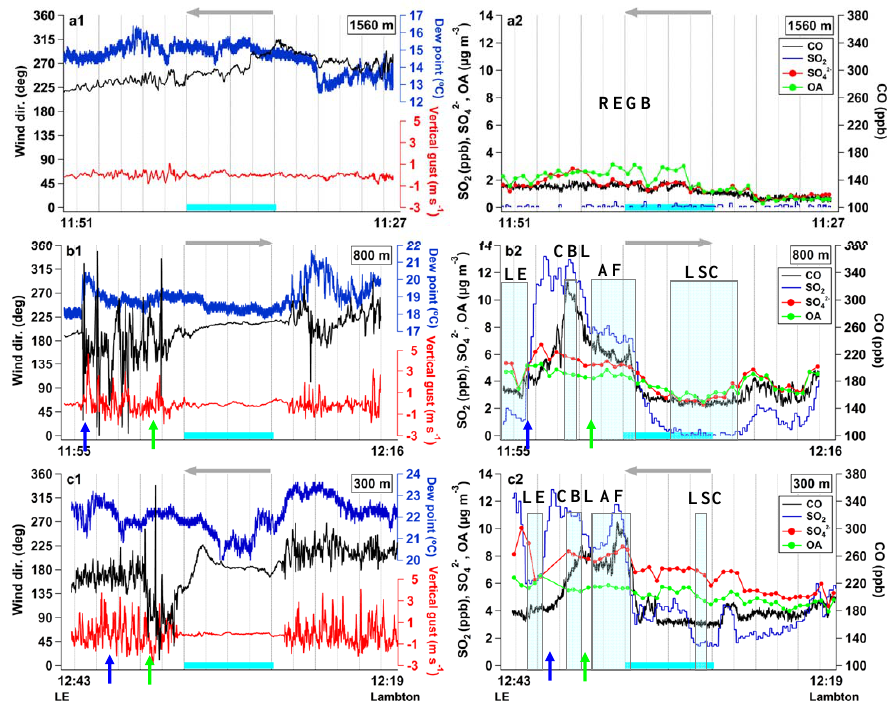
Fig. 3. Flight 4 wind direction, dewpoint, vertical gust velocity, SO 2 , SO 2 − , OA, and CO measured from the aircraft along tracks at a) 4 1560ma.g.l., b) 800ma.g.l., and c) 300ma.g.l. over LSC. Blue bar along horizontal axis=LSC; coloured arrows indicate lake breeze fronts (blue=LE, green=LSC). Data are plotted so that LE is on the left and Lambton is on the right of the x-axis and the direction of the aircraft transect is depicted as a grey arrow. Light blue boxes are selected time slices discussed in Sect.